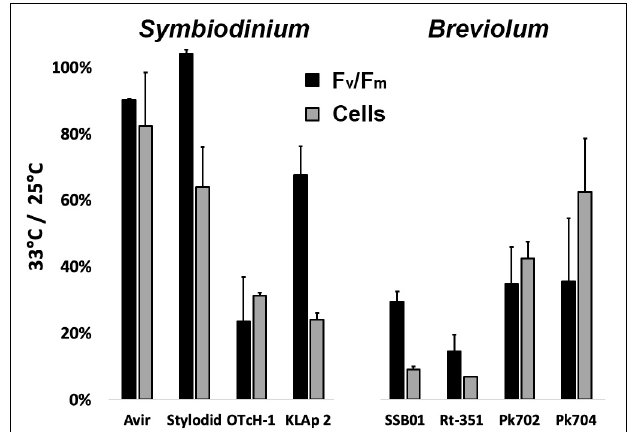
FIGURE 1 | Impact of long-term thermal stress (33 ◦ C) on Symbiodinium and Breviolum strains. Changes in the maximum quantum yield (F v /F M ) and in cell number after 18 days of heat treatment at 33 ◦ C in 12 h: 12 h light-dark cycle. Results are reported as percentage of the values measured on cells maintained at the control temperature of 25 ◦ C. All measurements were performed on three biological replicates and data are presented as means ± SD.